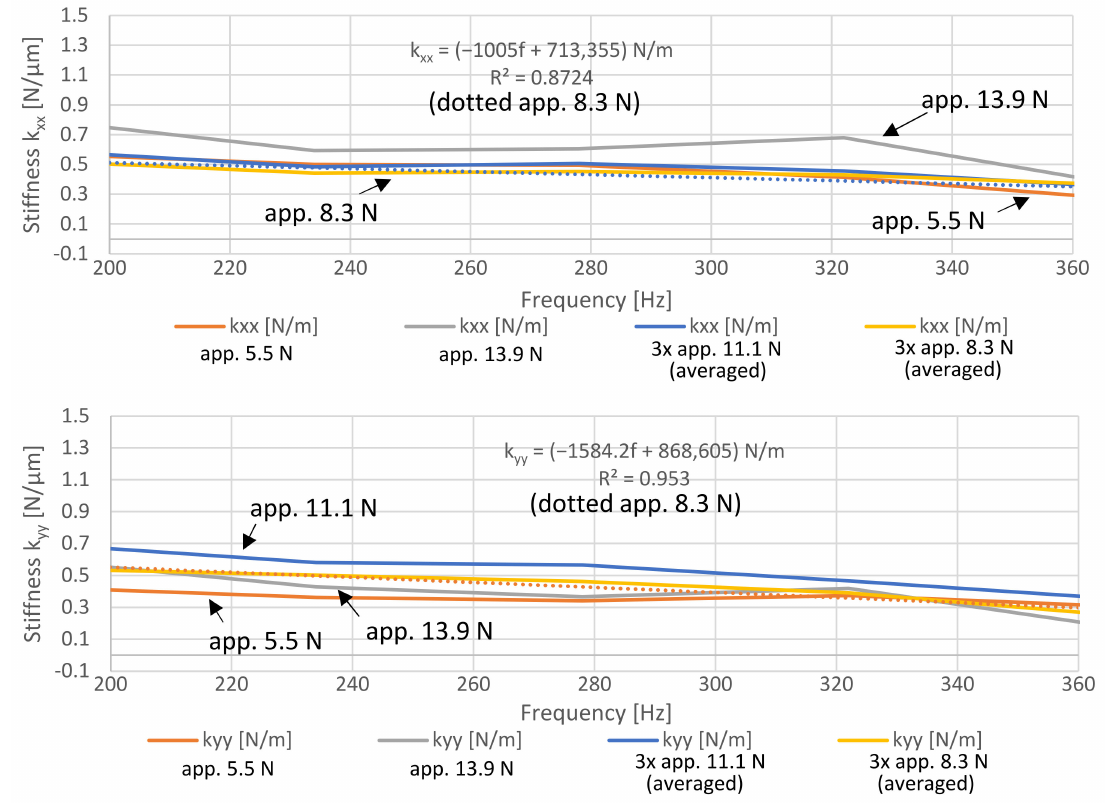
Figure 10. Stiffness: Displacement controlled (20 µ m); changing static loads between app. 5.5–13.9 N.